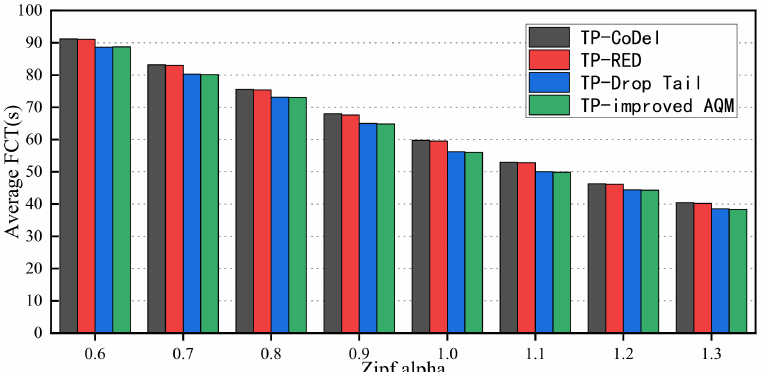
Figure 13. The average FCT under different Zipf alpha.